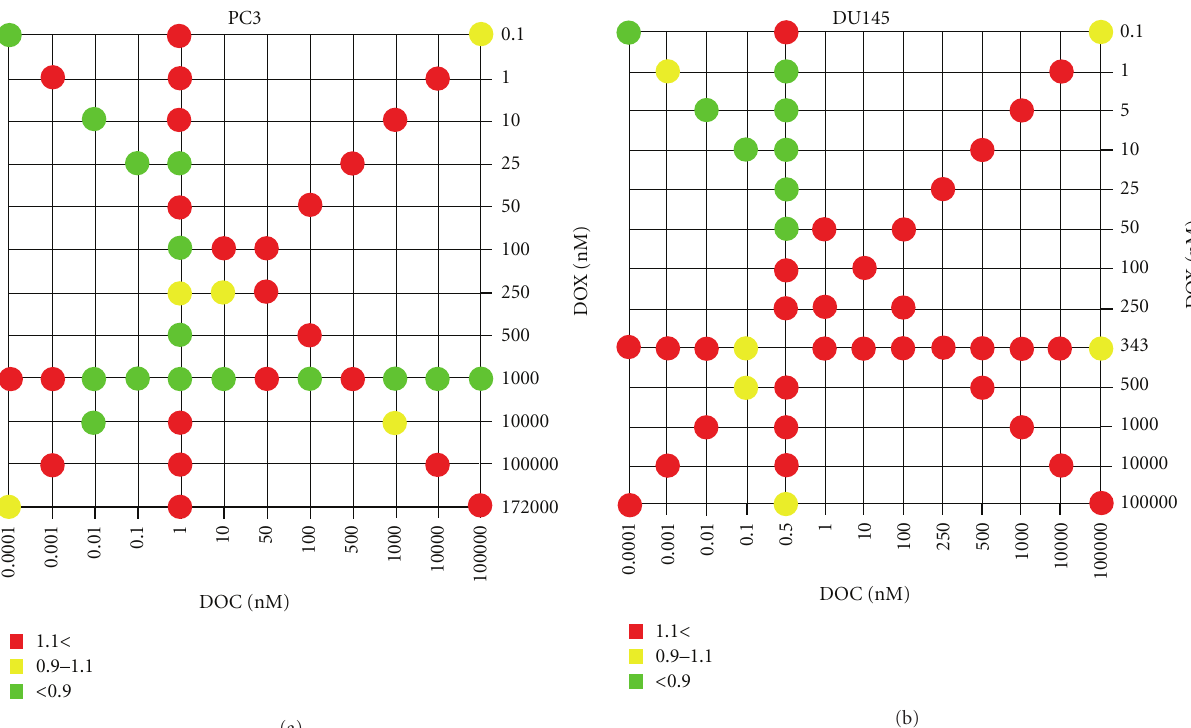
Figure 3: Synergy maps compiling combination index (CI) values. The dots in the figure indicate antagonism (CI > 1 . 1, red), additivity (0 . 9 < CI < 1 . 1, yellow), and synergism (CI < 0 . 9, green) between DOC and DOX against PC3 and DU145 cells at combination settings shown in Figure 1. Experiments were performed in